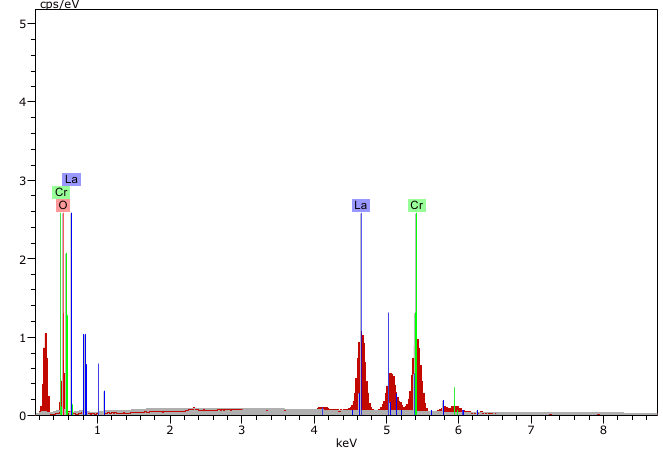
Figure 6. EDX spectra of LaCrO 3 .